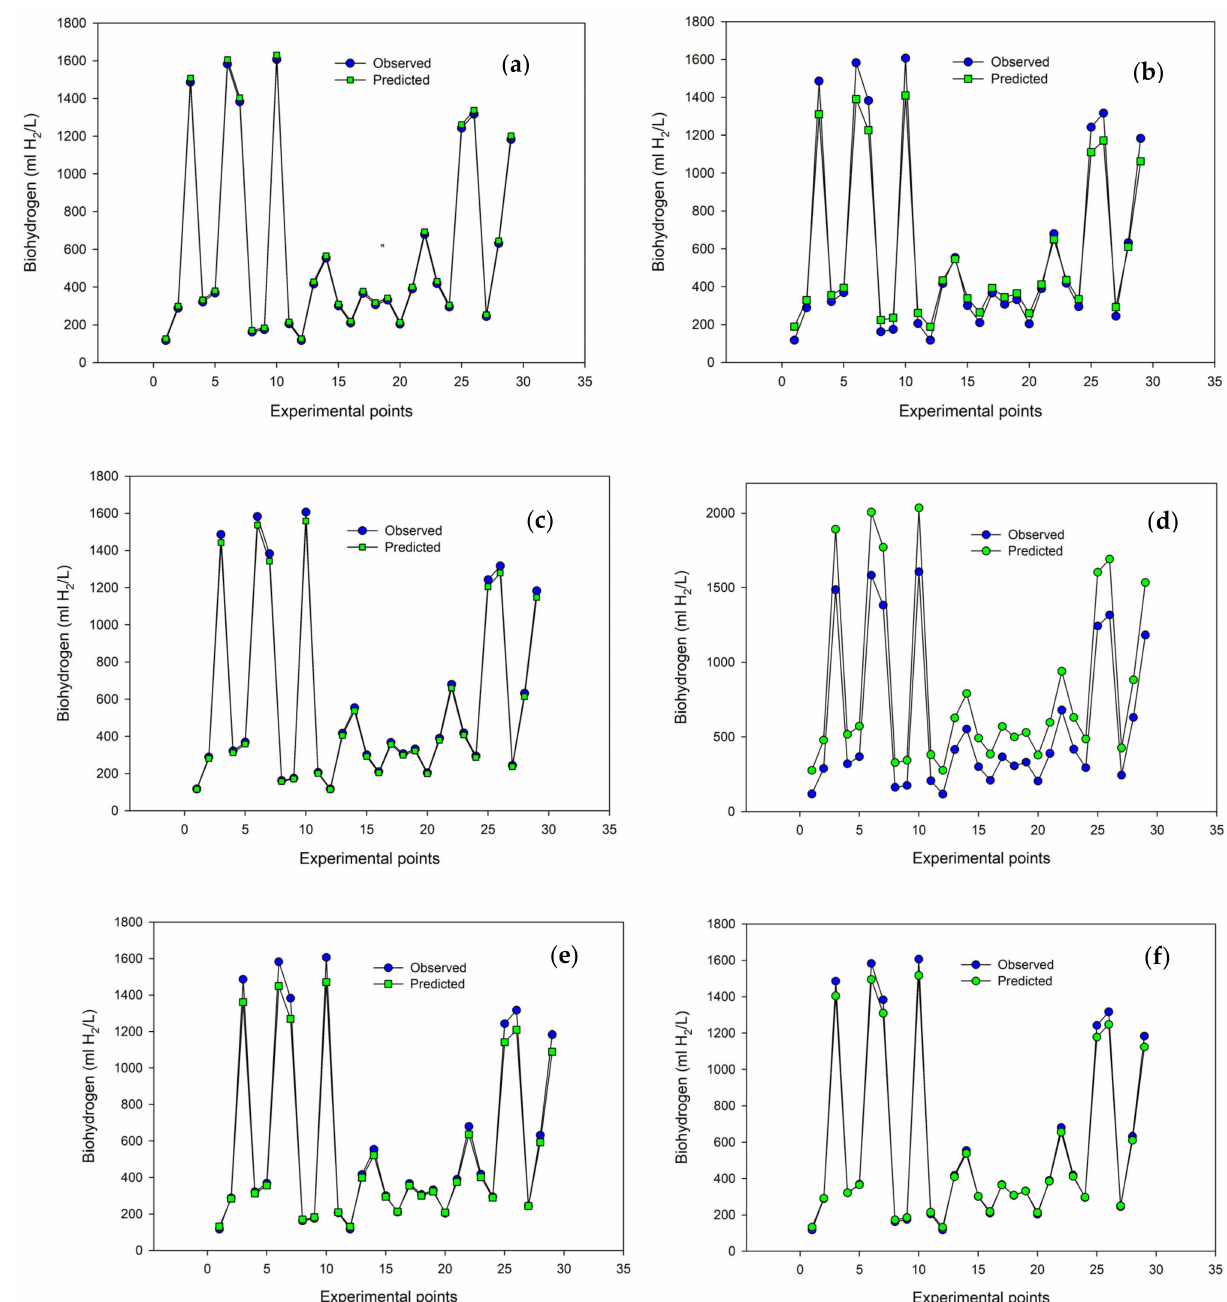
Figure 5. Comparison between the actual and predicted biohydrogen using ( a ) MLPNN-1 ( b ) MLPNN-2 ( c ) MLPNN-3 ( d ) MLPNN-4 ( e ) MLPNN-5 ( f ) MLPNN-6 with a scaled conjugate gradient optimization